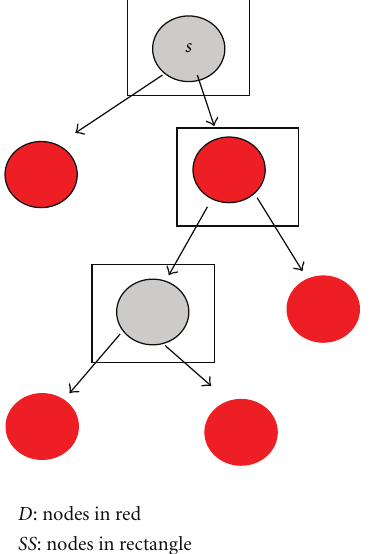
Figure 3: Multicast tree example: node s sends a message to multi- ple destinations in D through the